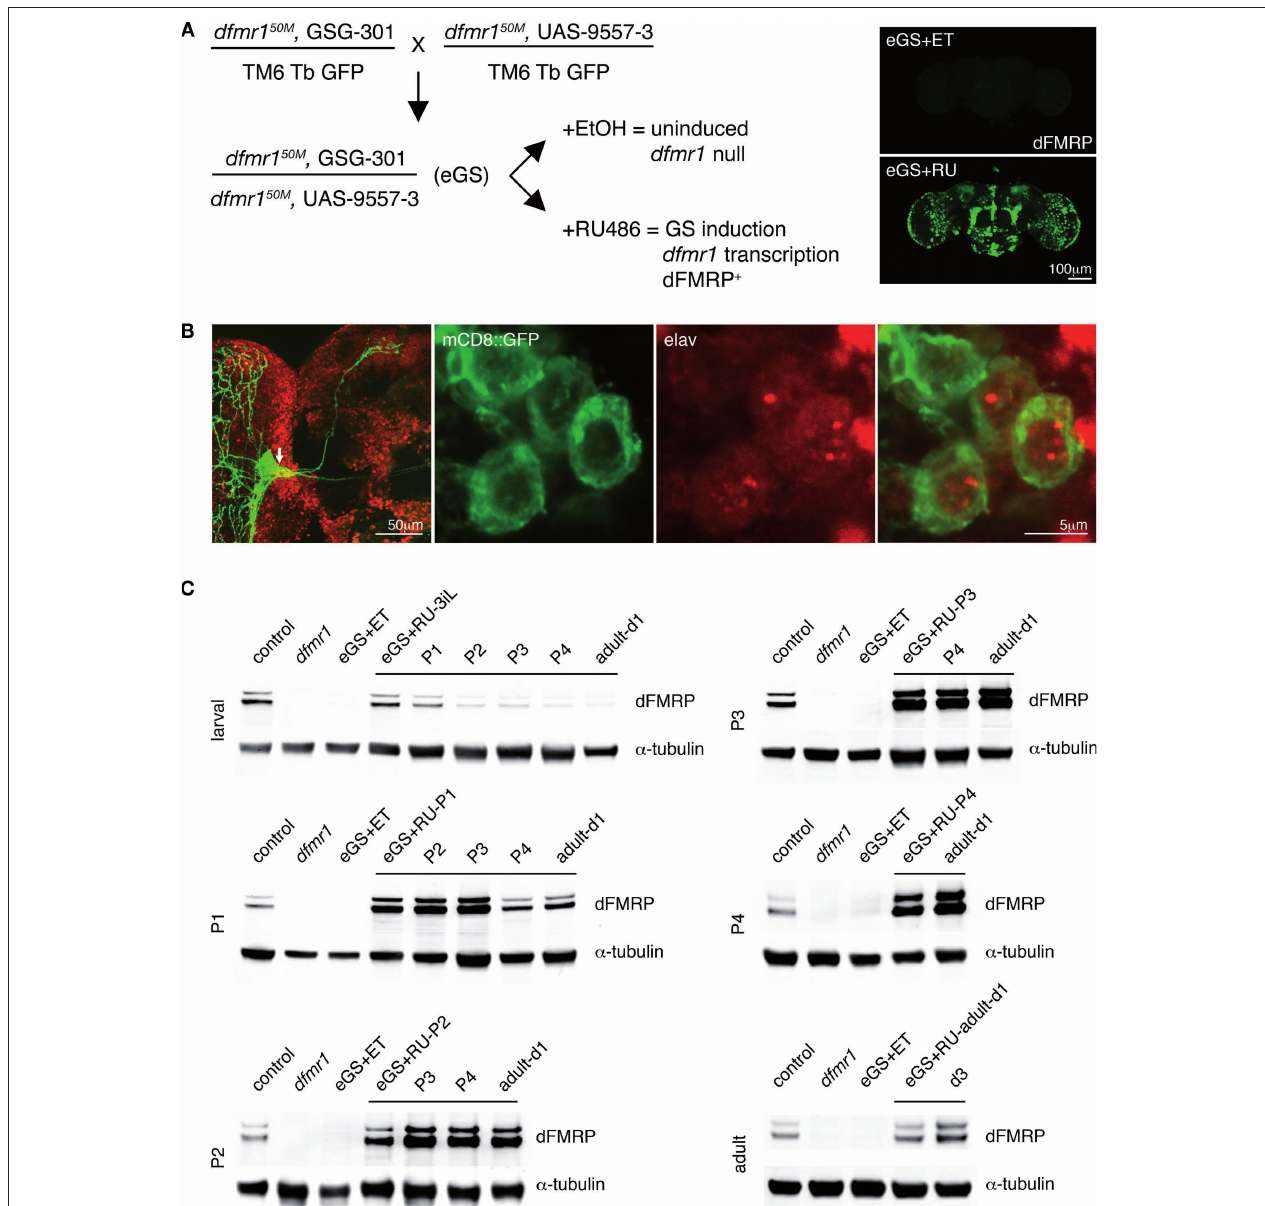
FIGURE 2 | Gene-Switch conditional induction of dFMRP expression during staged periods throughout development and at maturity. (A) The transgenic crossing and treatment scheme used to mediate temporal control of dFMRP expression in the dfmr1 50M -null background using the Gene-Switch (GS) system. Homozygous dfmr1- null animals harboring the neuron-specifi c elav -GS driver (GSG-301) and UAS- dfmr1 transgene responder (UAS-9557-3) (eGS) were treated with vehicle (EtOH) alone or RU486 to generate the two matched populations for comparisons. Whole brain imaging (inset, right) illustrates typical patterns of dFMRP immunostaining after adult-onset induction with RU486. (B) Representative images of adult Drosophila brains expressing a UAS-mCD8::GFP